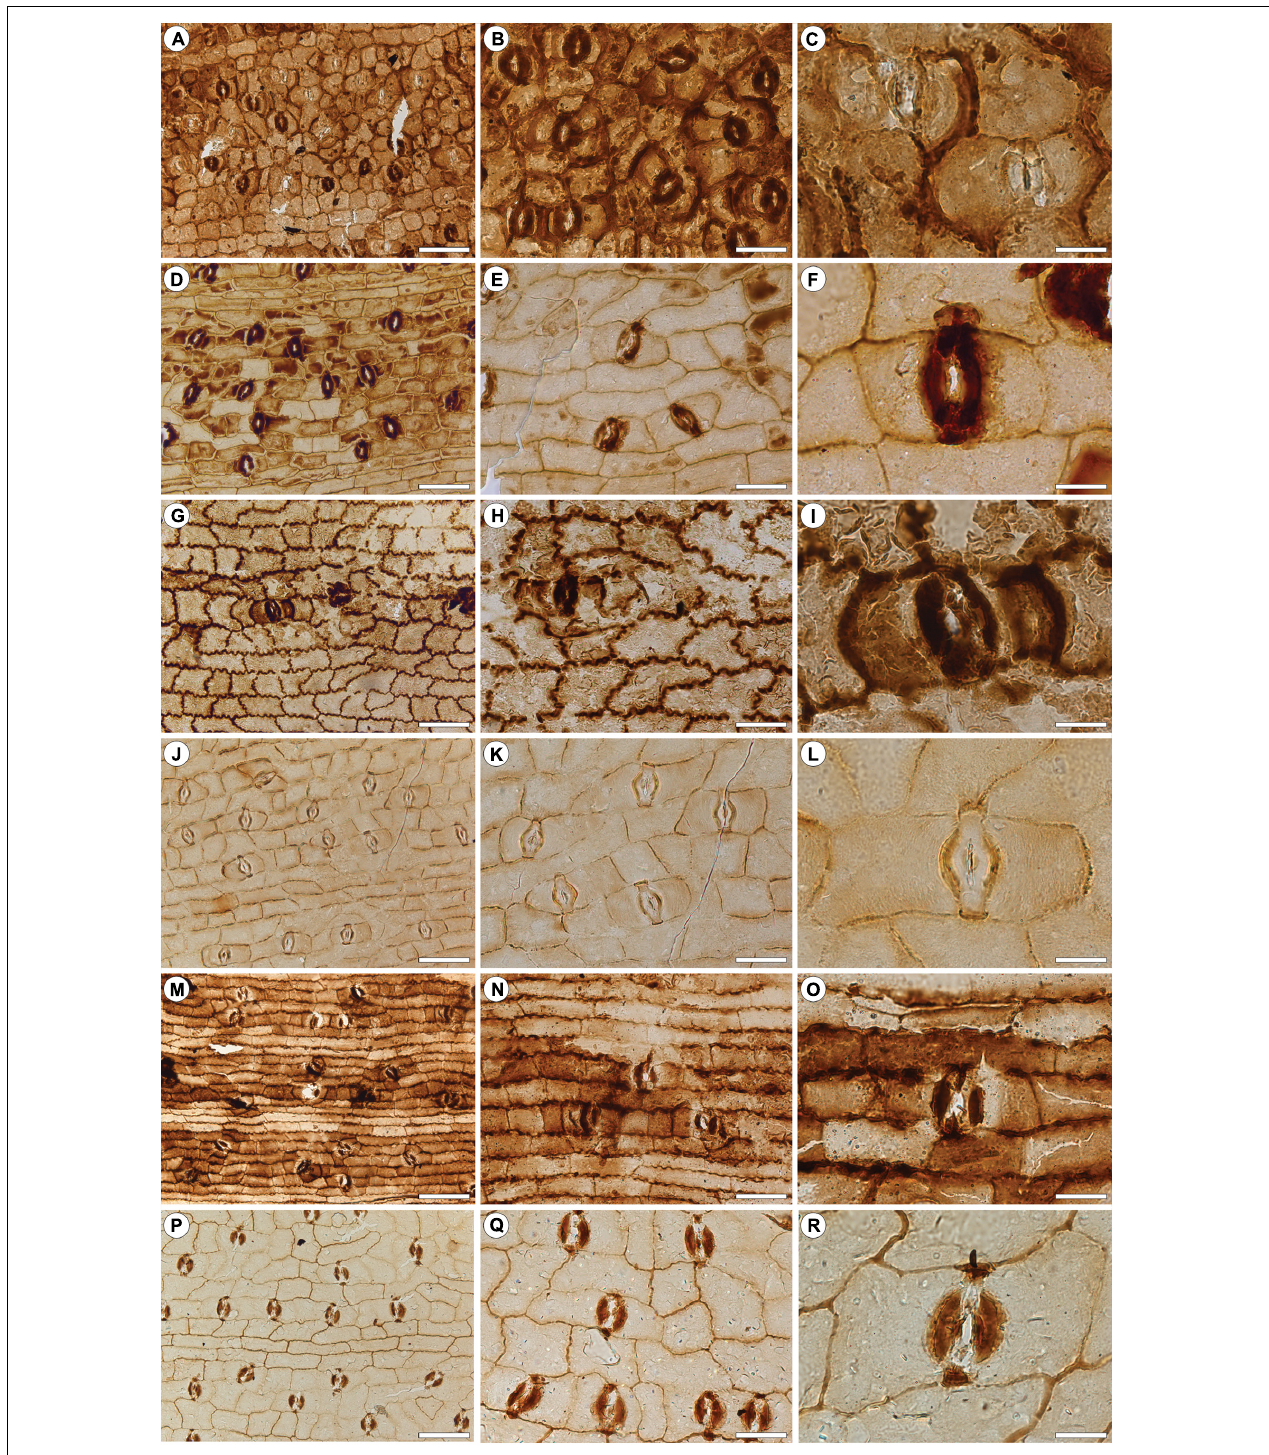
FIGURE 3 | Dispersed bennettitalean cuticles recovered by bulk maceration from the upper Permian of Jordan. Type A (A–C) ; Type B (D–F) ; Type C (G–I) ; Type D (J–L) ; Type E (M–O) ; Type F (P–R) . (A) Presumed lower leaf surface. (B) Detail of (A) showing the costal field. (C) Typical stomata. (D) Presumed lower leaf surface. (E) Detail of (D) showing the costal field. (F) Typical stoma. (G) Presumed upper surface. Note the comparatively strongly sinuous anticlinal walls. (H) Detail of (G) . (I) Typical stoma. (J) Presumed lower leaf surface. (K) Detail of (J) showing a costal field. (L) Typical stoma. (M) Presumed lower leaf surface. Note the comparatively strongly elongate epidermal cells in intercostal fields and sinuate anticlinal walls. (N) Detail of (M) showing the costal field. (O) Typical stoma. (P) Presumed lower leaf surface. (Q) Detail of (P) showing the costal field. Note the slightly sinuate epidermal cells within the costal field. (R) Typical stoma. Scale bars for (A,D,G,J,M,P) = 100 µ m; (B,E,H,K,N,Q) = 50 µ m; (C,F,I,L,O,R) = 20 µ m.